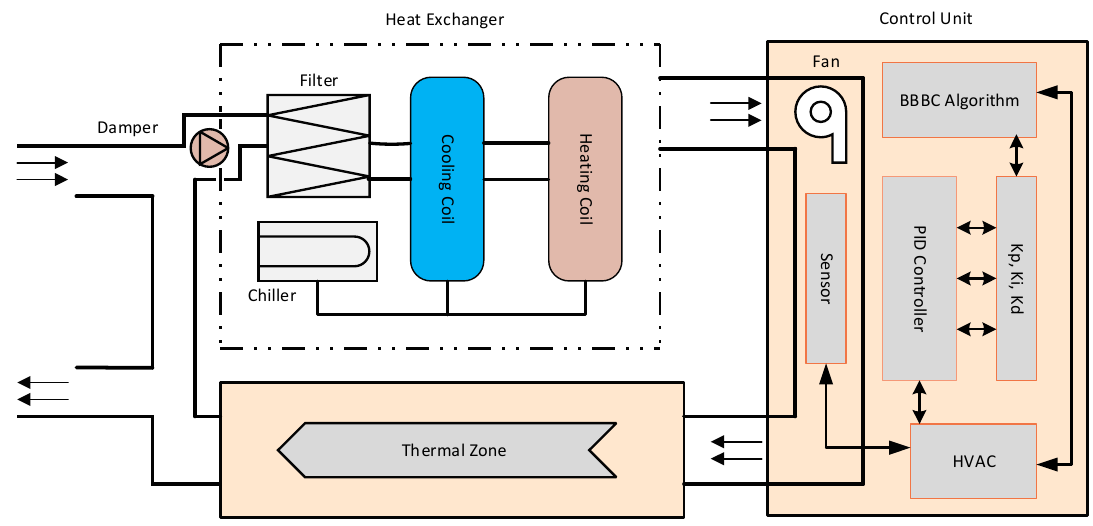
Figure 3. Block diagram of conventional HVAC system and control unit structure.